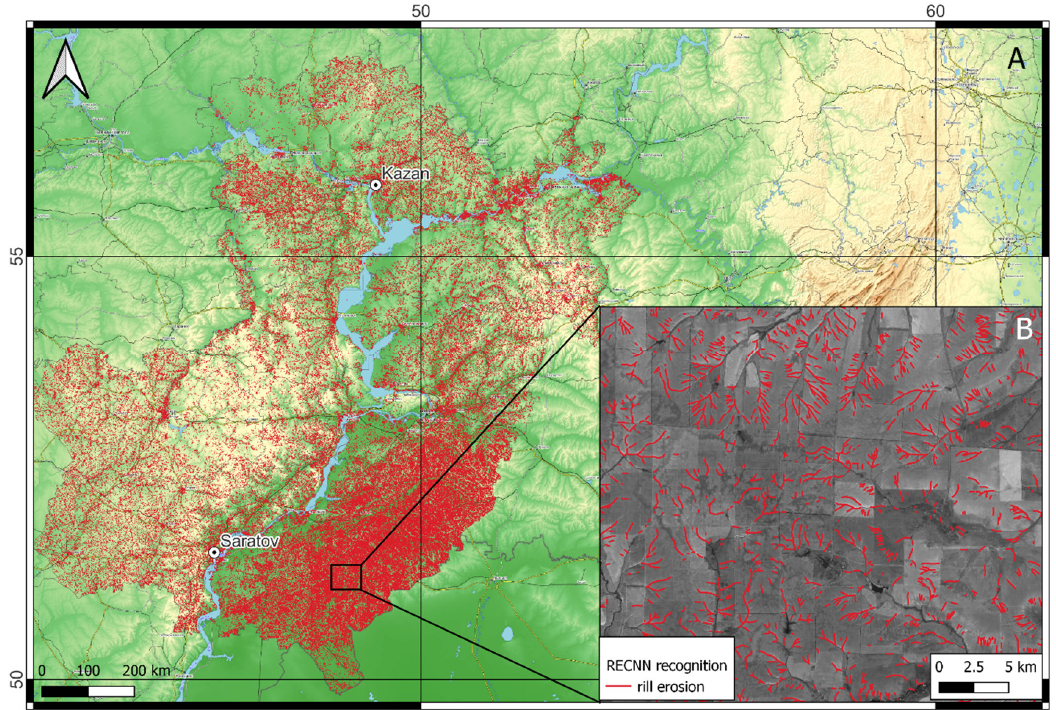
Figure 6. Results of rill erosion recognition over the entire study area ( A ) and enlarged area with recognized streams in Sentinel 2 image ( B ).